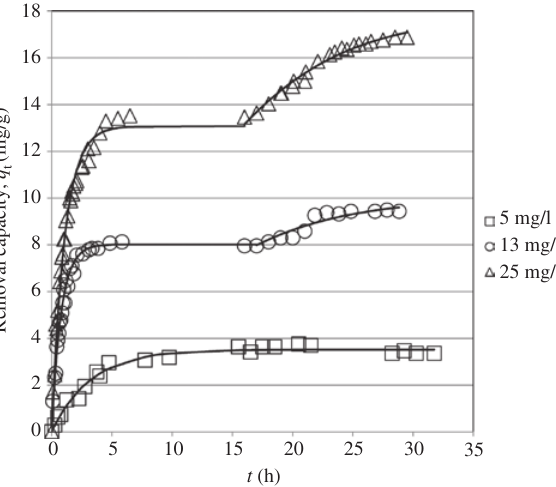
Figure 5: Rate of methylene blue adsorption by basic-treated human hair adsorbent (Lines were predicted by pseudo-first-order and S-shaped kinetics